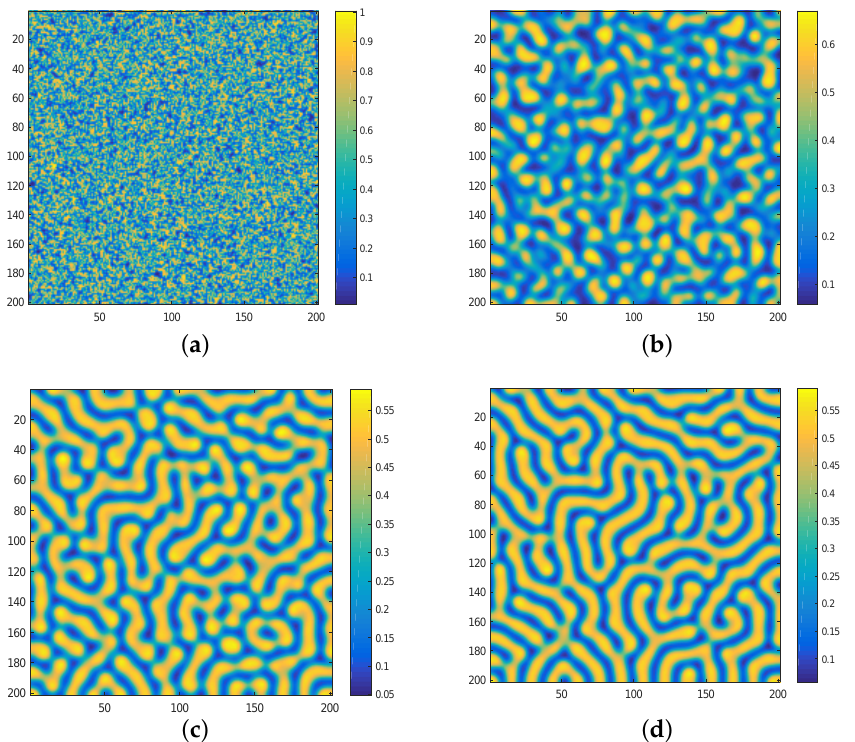
Figure 4. The patterns of u at c = 0.7, the other parameters are fixed as in (23). Times: ( a ) t = 0, ( b ) t = 50, ( c ) t = 200, ( d ) t =